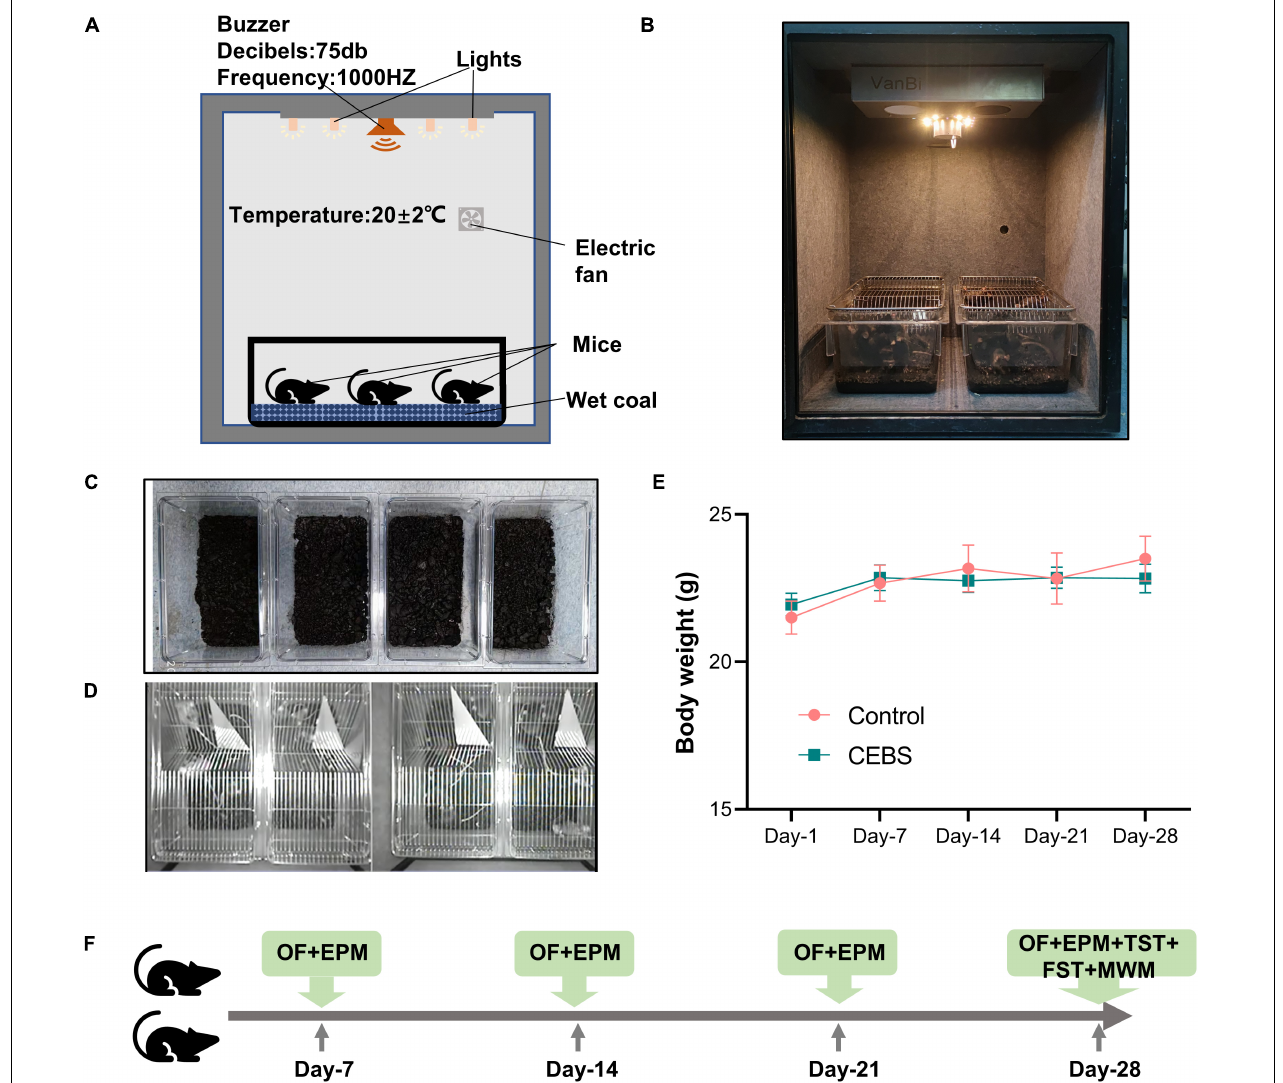
FIGURE 1 | Diagram of the coal mine environment simulator and the overall experimental workflow. The simulation box was used to construct the CEBS model (A,B) ; the coal ground (C) ; video screenshot of the modeling process (D) ; mice were weighed weekly (E) . The overall modeling and experimental procedures of this study (F) . On modeling days 7, 14, 21, and 28, EPM and OF tests were used to detect anxiety-like behavior. TST and FST were used to detect depression-like behavior on day 28, followed by a 5-day Morris water maze test on the modeling day 29 to detect spatial memory and learning ability. EPM, elevated plus maze; OFT, open field test; FST, forced swimming test; TST, tail suspension test; MWM, Morris water maze. Data are mean ± SEM from n = 6 mice (Control), n = 20 mice (CEBS: Days 1, 7, 14, and 21), and n = 14 mice (CEBS: Day 28) (E)